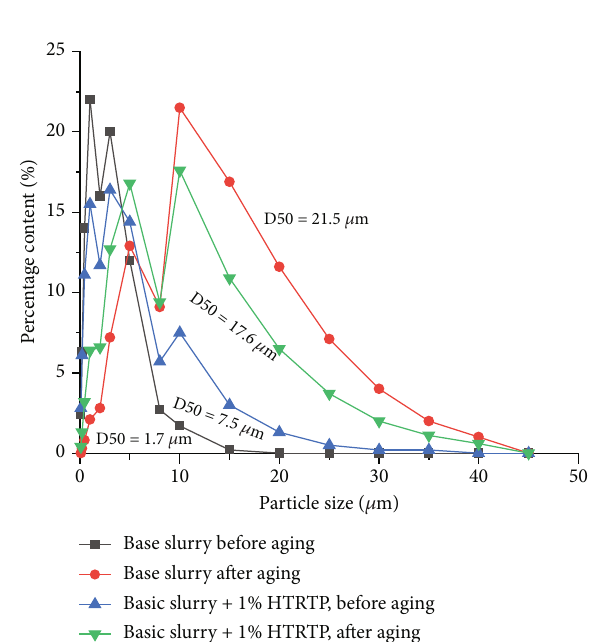
Figure 9: Test results of particle size